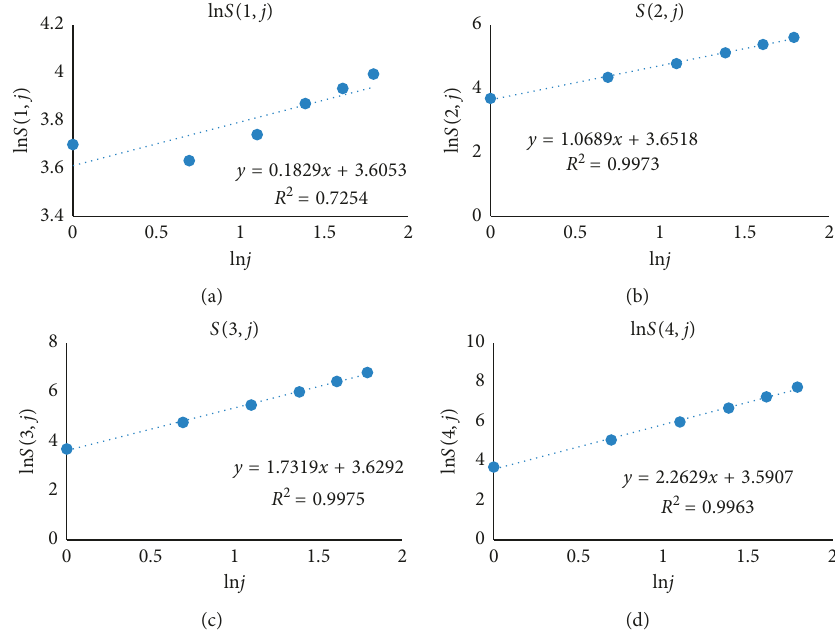
Figure 8: 4 cumulative sequence curves of speed: (a) first, (b) second, (c) third, and (d) fourth.